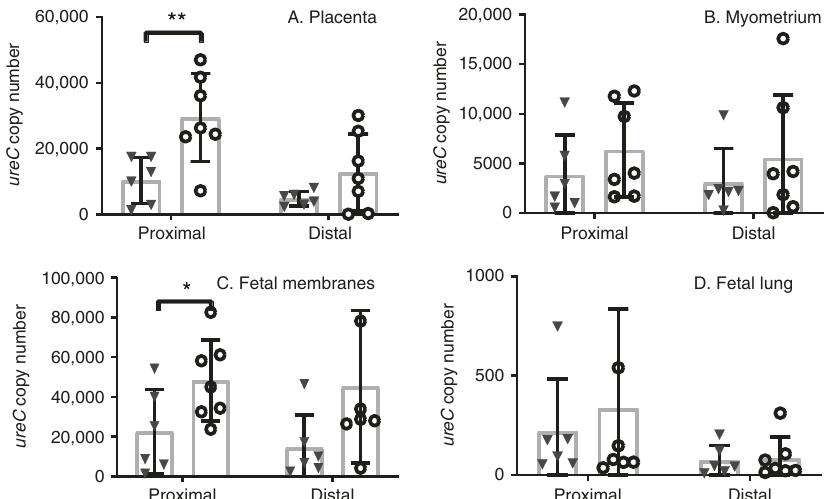
Fig. 6 Higher UP levels in gestational in the presence of cervical damage. In the afternoon of D16 of gestation, mice received either 10% N-9 in PBS or PBS control via intravaginal inoculation. After 16 h, in the morning of D17 of gestation, mice received either Ureaplasma parvum (UP) in ureaplasma-selective medium (USM) or USM control via intravaginal inoculation. After 48 h, in the morning of D19, gestational tissues were analysed for ureC mRNA expression. In mice pre-treated with N-9 ( n = 7), there was a signi fi cant increase in ureC copy number at the proximal sites of the placenta and the foetal membranes compared to pre-treatment with PBS ( n = 6) and a trend increase in all other tissues and sites ( a – d ). No ureC copies were detected in uninfected mice. Each dot in the dot plots represents the average of left and right horn for each mouse at either site. Error bars indicate SD . Statistical signi fi cance was assessed using unpaired t test for PBS + UP vs. N-9 + UP in all four tissues and at both sites (* P = 0.048 for N-9 + UP vs. PBS + UP at the foetal membranes ’ proximal site, ** P = 0.0093 for N-9 + UP vs. PBS + UP at the placental proximal site). Source data are provided as a Source Data fi le.